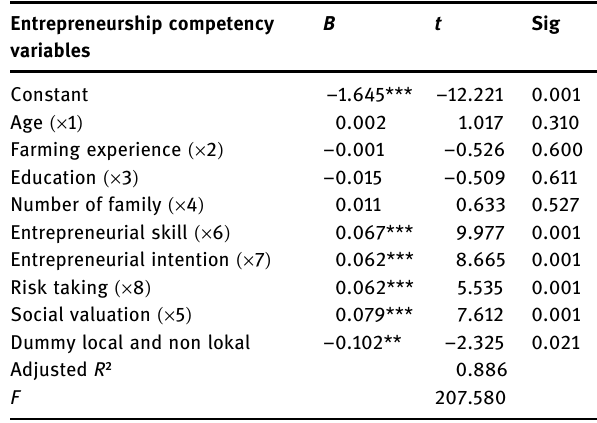
Table 15: Factors a ff ecting entrepreneurship competence for poor